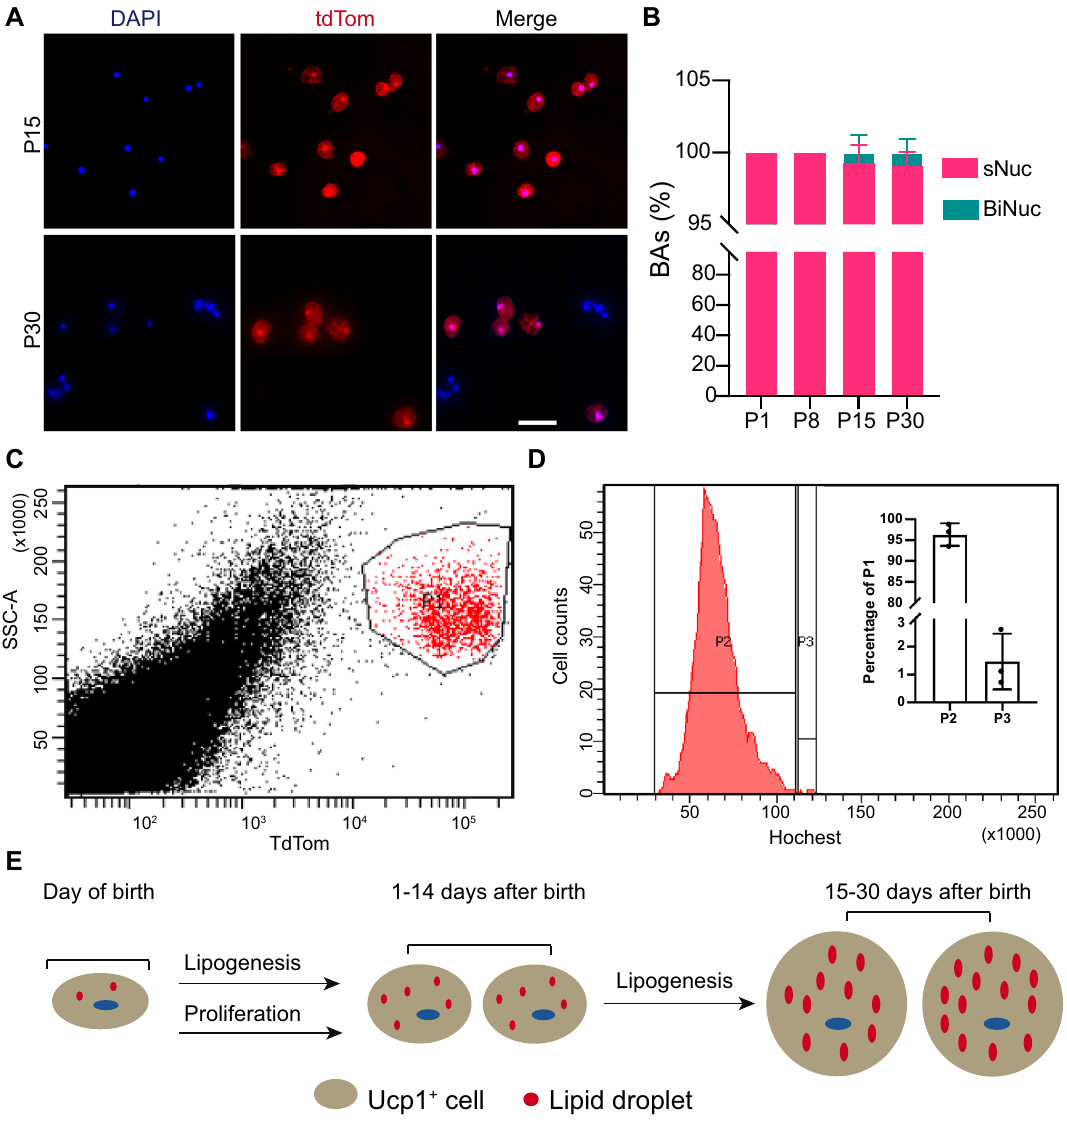
Figure 5. Evaluation of BAs nuclearity and DNA ploidy in juvenile mice. ( A ) Representative images of dissociated BAs. Bar = 50 µm. ( B ) Measurement of BAs nuclearity at P1, P8, P15 and P30. Dissociated BAs were stained with DAPI and counted for nucleus number. Data were collected from three independent assays. sNuc: single nucleus. BiNuc: binucleus. ( C ) TdTom + BAs gating image . ( D ) DNA content histogram of gated tdTom + BAs. Population 2 (P2) and Population 3 (P3) represent diploid and tetraploid BAs, respectively. The cell number of P2 and P3 was normalized to the number of gated tdTom + BAs (P1), and calculated percentages were shown in the inset bar graph. N = 4. ( E ) Schematic summary of the current findings. In the first two weeks, BAT expands by increasing BAs number (proliferation) and size (lipogenesis); from P15 to P30, lipogenesis but not proliferation of the BAs contributes to BAT